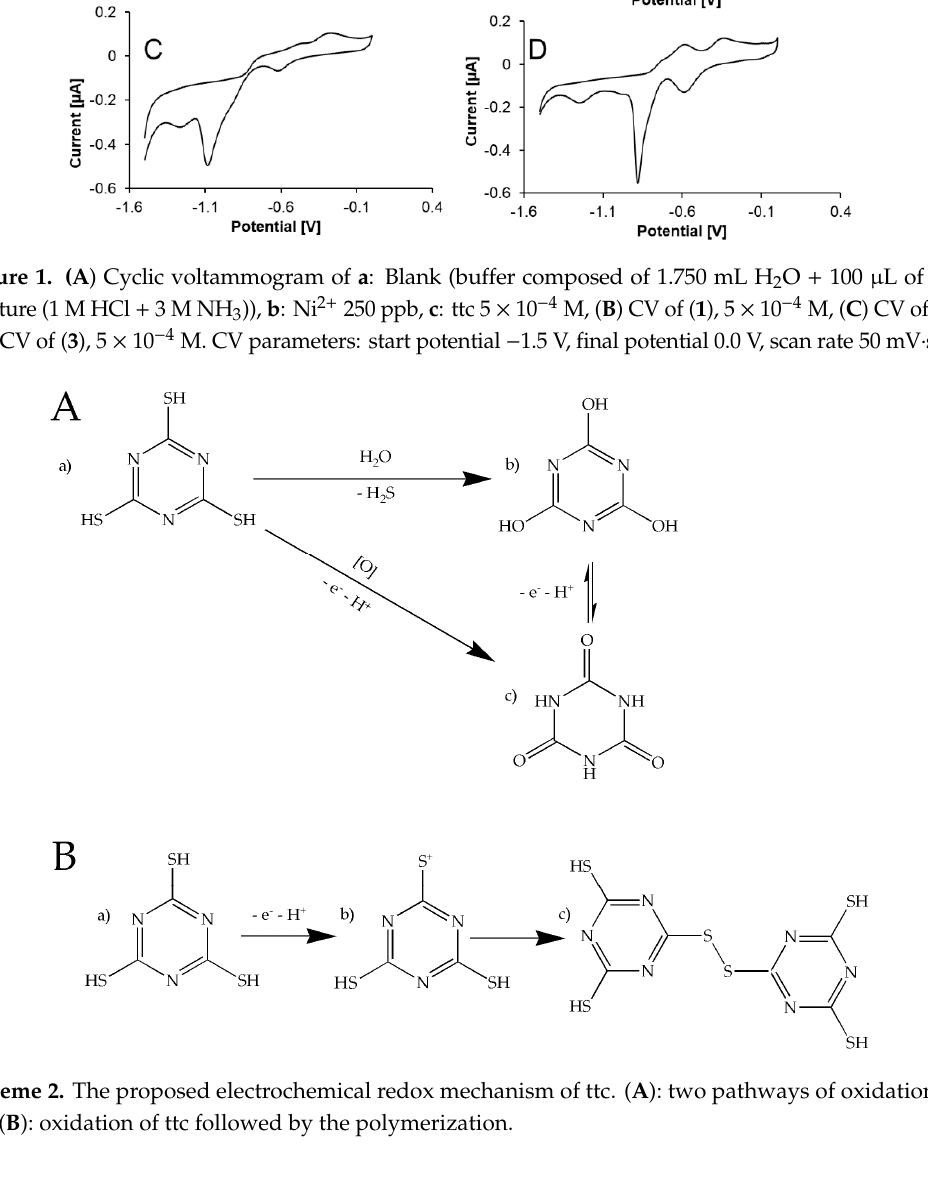
Figure 2. Testing of antimicrobial activity of complex 3 in concentration range 0.002–0.500 mg·mL − 1 after 21 h of treatment on S. aureus , E. coli, and MRSA .